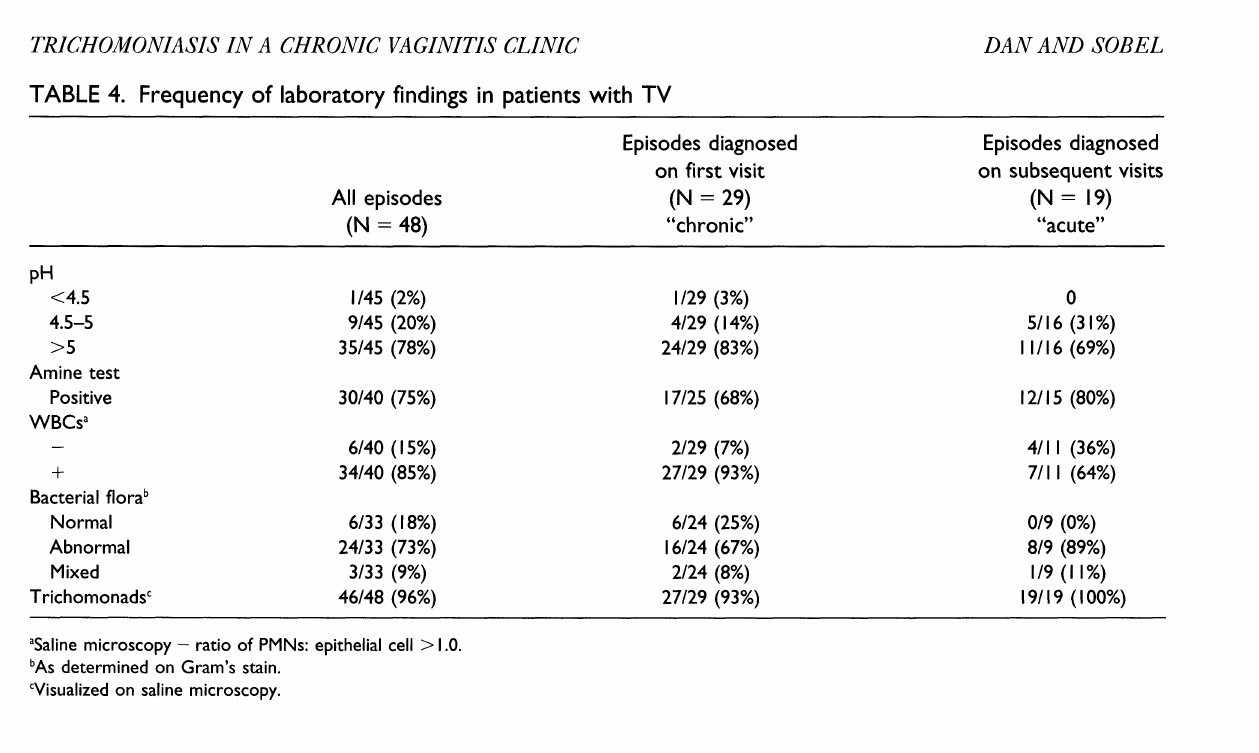
Episodes diagnosed Episodes diagnosed on first visit on subsequent visits (N All episodes (N 48) "chronic" "acute"